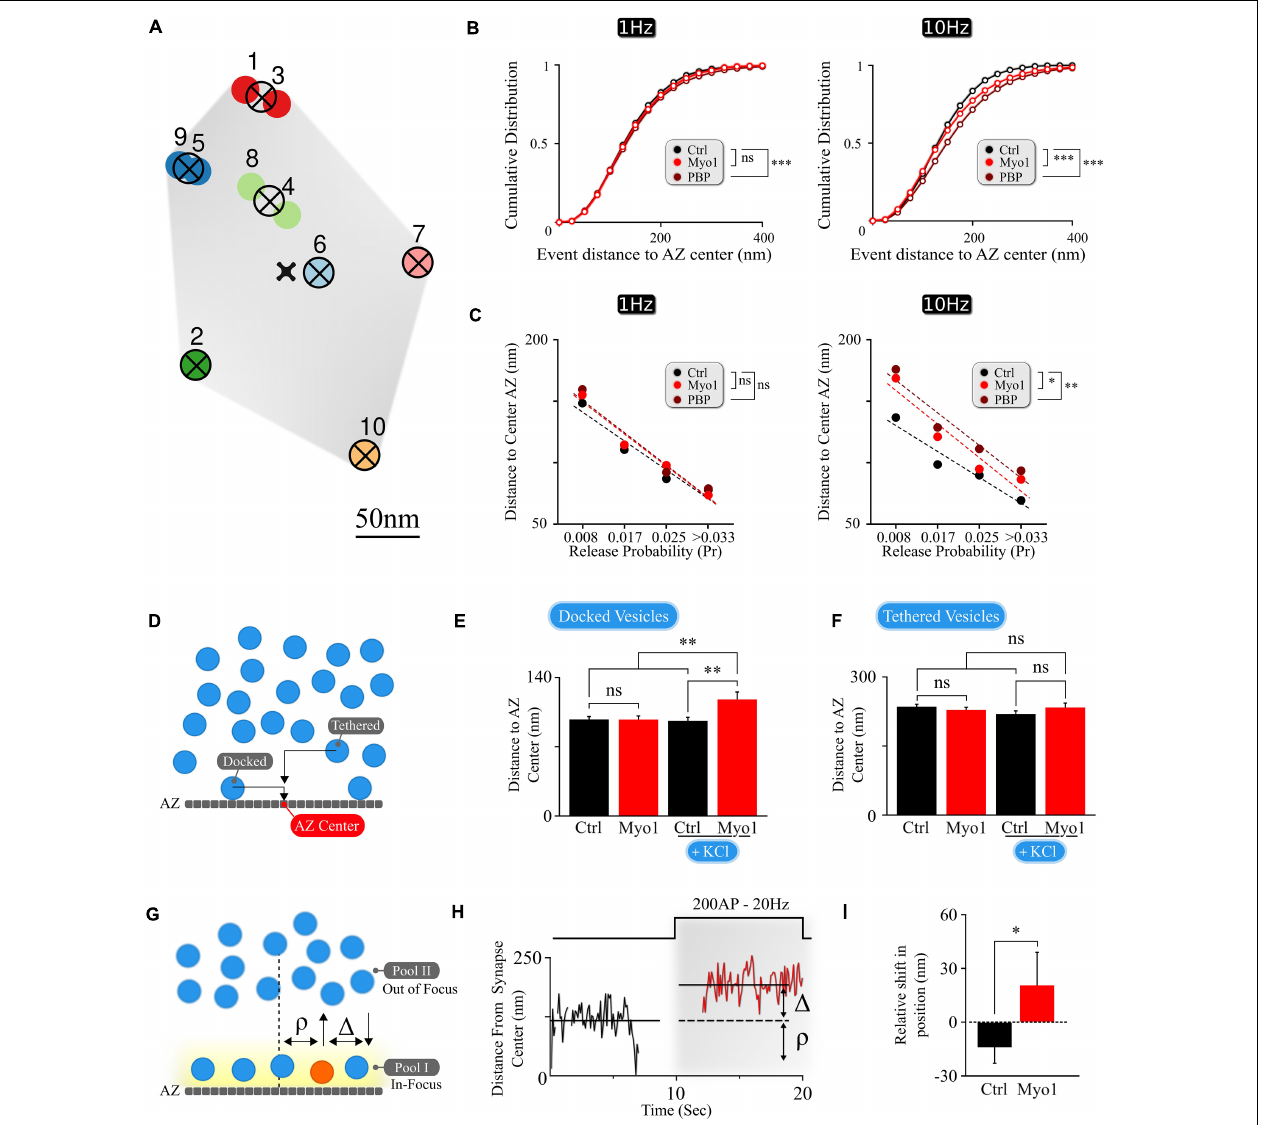
FIGURE 1 | The spatial localization of vesicle docking and release is myosin V -dependent. (A) Sample map of release events within a single hippocampal bouton evoked by 1 Hz stimulation, with 10 fusion events and 7 release sites. Hierarchical cluster analysis was used to define release event clusters [representing individual release sites (crossed circles)] with a clustering diameter of 50 nm. Events clustered into the same release site are shown by the same color. Scale bar = 50 nm. (B) Effects of myosin V inhibition with Myo-1 (red) or PBP (brown) on cumulative histograms of distances from vesicle release locations to the AZ center recorded at 1 Hz (left) or 10 Hz (right). (C) Effects of myosin V inhibition with Myo-1 (red) or PBP (brown) on the average distance to the AZ center for individual release sites for measurements at 1Hz (left) or 10 Hz (right), binned on the basis of their release probability. Note that errors of measurements are too small to be visible in this plot and the same data is presented as a bar-graph in Supplementary Figure 1 . (D) Cartoon representation of the analysis of LaSEM measurements in individual hippocampal boutons in cultures depolarized (or not) by KCl application (55 mM) for 10 min in the presence or absence of Myo-1 (20 min), immediately followed by fixation. Vesicles were considered as ‘docked’ when the distance from the vesicle center to AZ was under 30 nm and ‘tethered’ when the distance was under 100 nm. (E,F) Effects of myosin V inhibition with Myo-1 on the localization of docked vesicles (E) or tethered vesicles (F) , with or without KCl depolarization, plotted as the mean distance to AZ center (nm). (G) Cartoon representation of vesicle re-docking measurements using single-vesicle tracking. Vesicle disappearance/reappearance events are caused by vesicle moving out-of/back in-to the focal plane near the AZ, due to vesicle shuttling between the docking locations at the AZ and the inner vesicle pool. The relative shift in vesicle position upon re-docking was determined as a difference ( (cid:49) ) of vesicle initial docking location before disappearance ( ρ ) and its subsequent position after re-appearance/re-docking, both measured relative to the synapse center. (H) Example of a single vesicle track, measured relative to the synapse center, showing a disappearance/re-appearance event. Vesicle re-appeared (red) during a 200AP, 20 Hz stimulus train farther (by (cid:49) nm) from the initial disappearance location ( ρ ). (I) Quantification of the shift in vesicle re-appearance/re-docking location. The shift in vesicle location was determined as a difference in the exponential fits to the aggregate distributions of vesicle locations ( Supplementary Figure 1C ) separated as toward synapse center versus toward periphery relative to the vesicle initial location (defined as a point of 0 shift). Errors are residual sum of squares from the exponential fits. Statistical significance was evaluated using KS-test of cumulative distributions toward the periphery for each condition. Two-sample t -test (C,E,F) or two-sample KS-test of cumulative distributions (B,I). ∗ p < 0.05, ∗∗ p < 0.01, *** p < 0.001, ns, not significant.